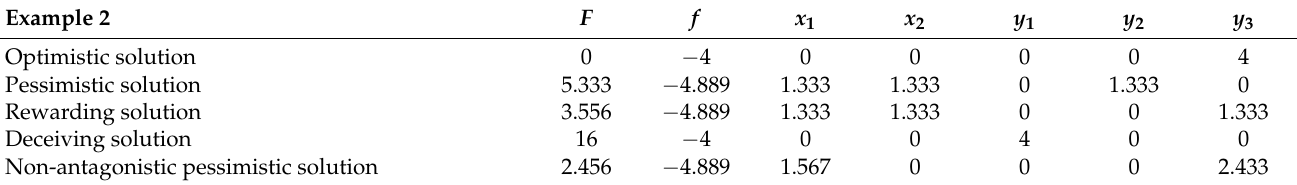
Table 2. The solutions and optimal values of Example 2.